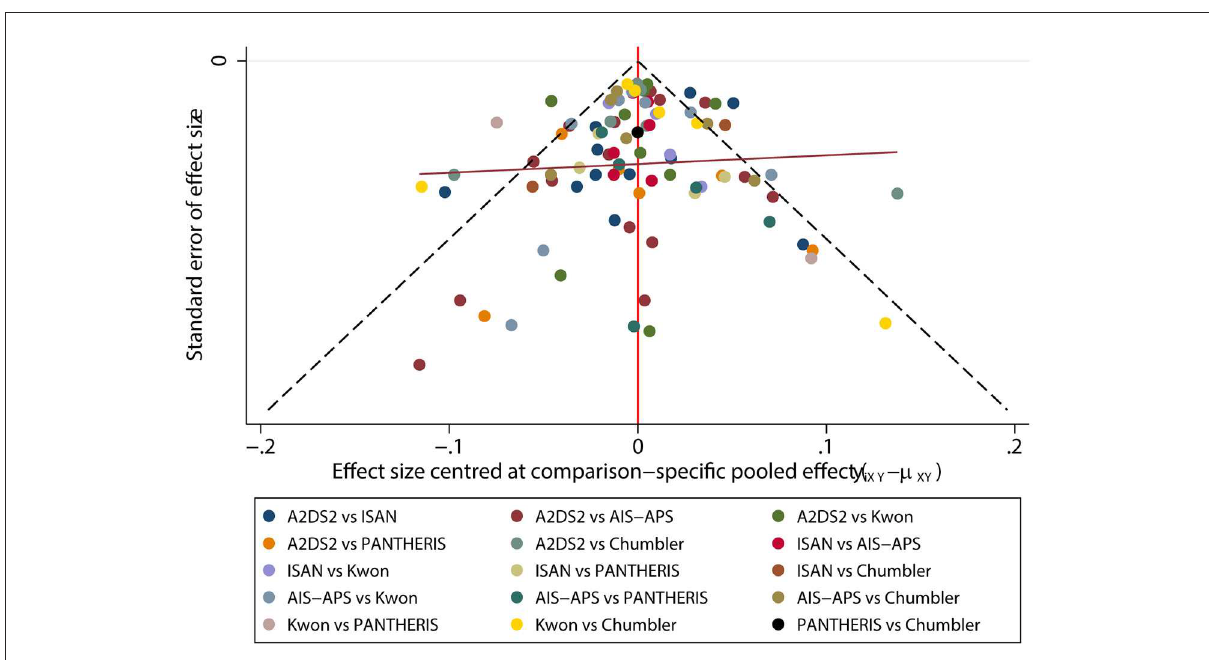
FIGURE8 Funnel plot.